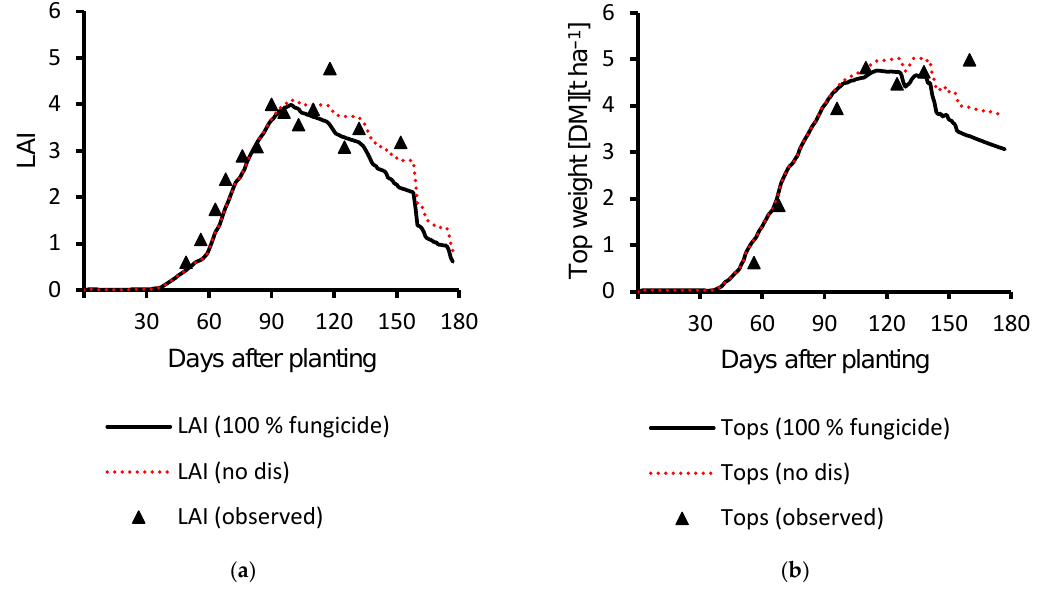
simulated with current genetics without disease ratings being included in simulation process—(red) dotted line), but a result of a structural issues within the model.